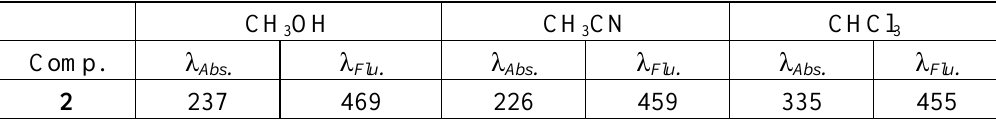
Table 1. Photophysical data: electronic absorption ( Abs. ) and fluorescence ( Flu. ) of 2 .